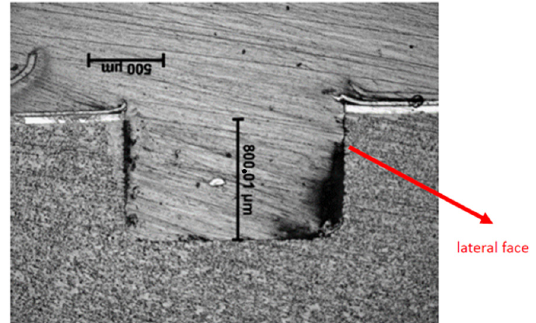
Figure 10. Cross-sectional view of the drilled hole in the GFRP sample.